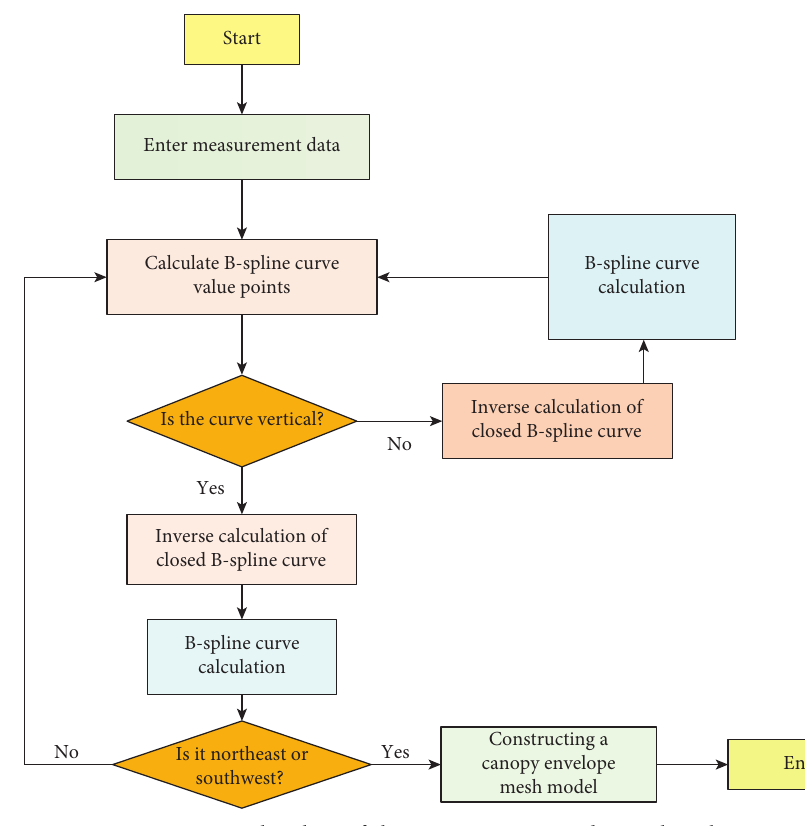
Figure 5: Flowchart of sheet music recommendation algorithm.